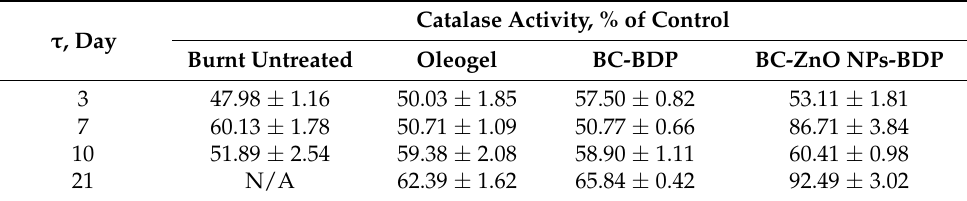
Table 11. Catalase activity under the treatment with the studied agents (% of control) 1,2 . Catalase Activity, % of Control τ , Day